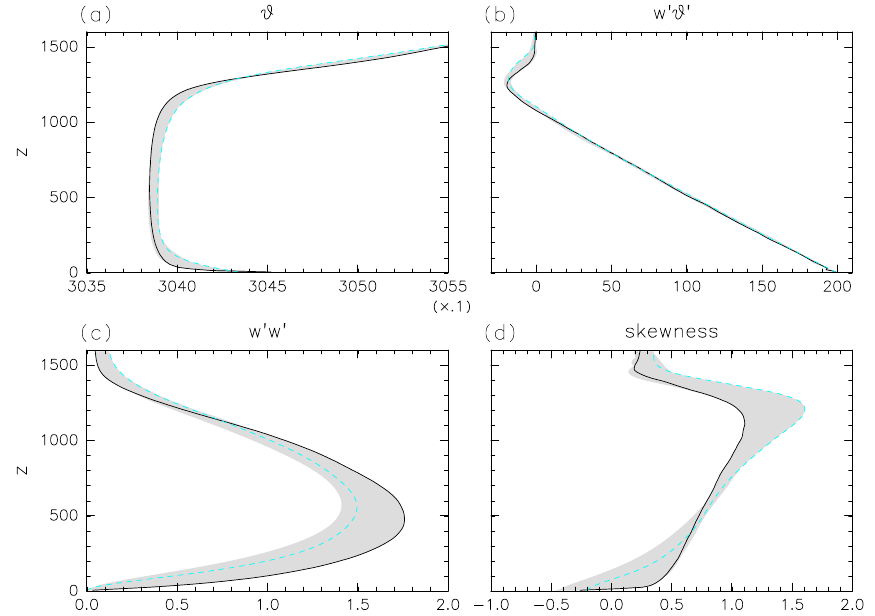
Figure 5. Vertical plots of horizontal mean (a) potential temperature [K], (b) heat flux [Wm − 2 ], (c) variance of vertical velocity [m 2 s − 2 ], and (d) skewness of vertical velocity in the control experiment. These values are averaged over t = 3 . 5 to 4h. Black and cyan lines are results of 10mAR1 and 5mAR20 runs, respectively. Shaded areas represent range between maximum and minimum of all runs in the control